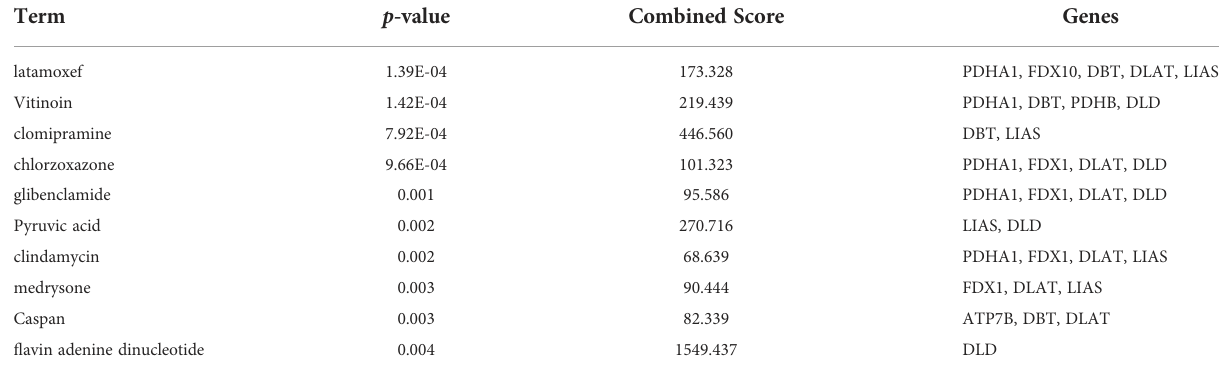
TABLE 4 Therapeutic agents for cuproptosis-related genes.